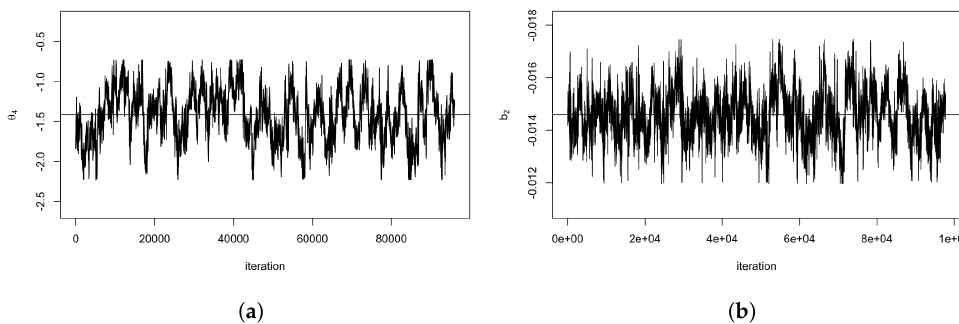
Figure 4. Trace plots, ( a ) trace plot for θ 4 , ( b ) trace plot for b 2 .